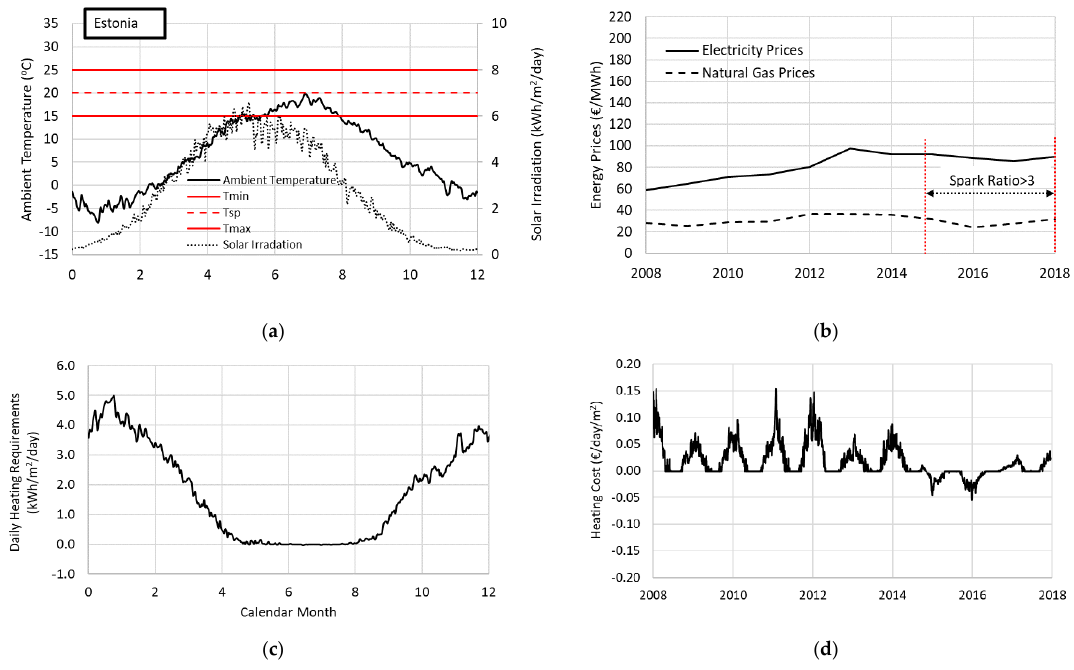
Figure 8. Evolution of seasonal greenhouse energy cost in Estonia during the 2008–2018 period. Summarized results of ( a ) climatic conditions, ( b ) evolution of energy prices, ( c ) energy requirements, and ( d ) evolution of energy cost.